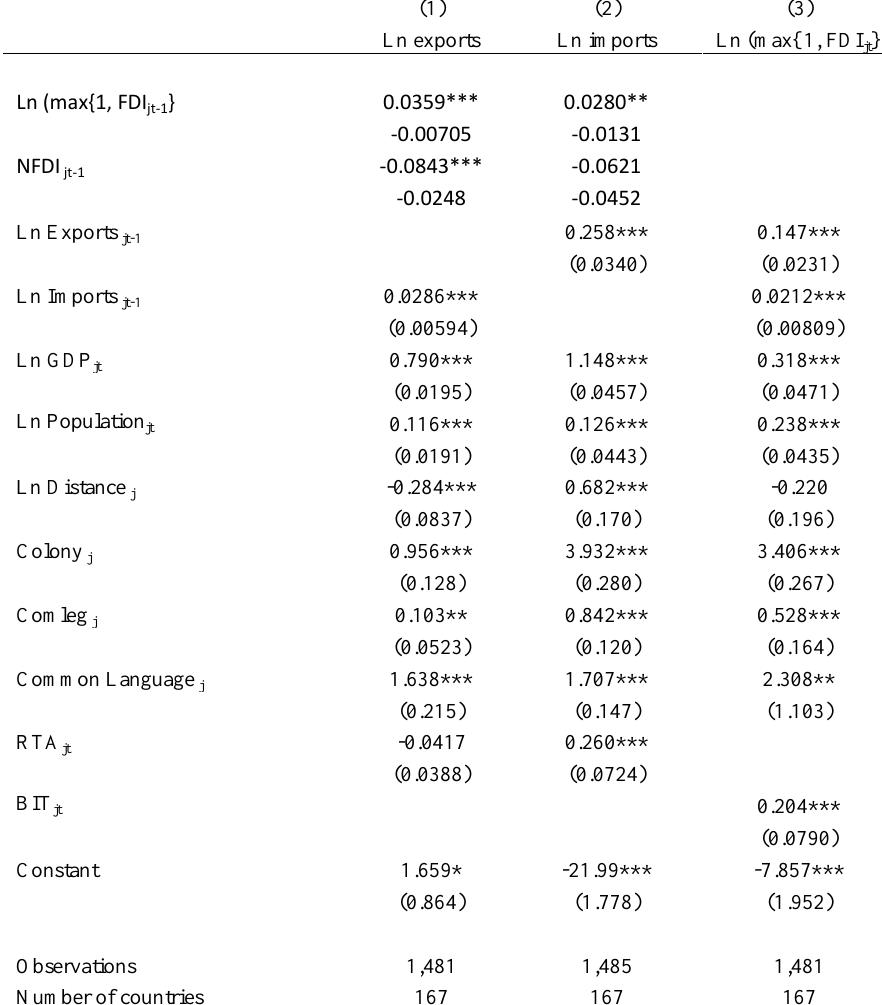
Table A3 . Results with Feasible Generalized Least Squares (with continental dummies and country RE allowing for panel specific